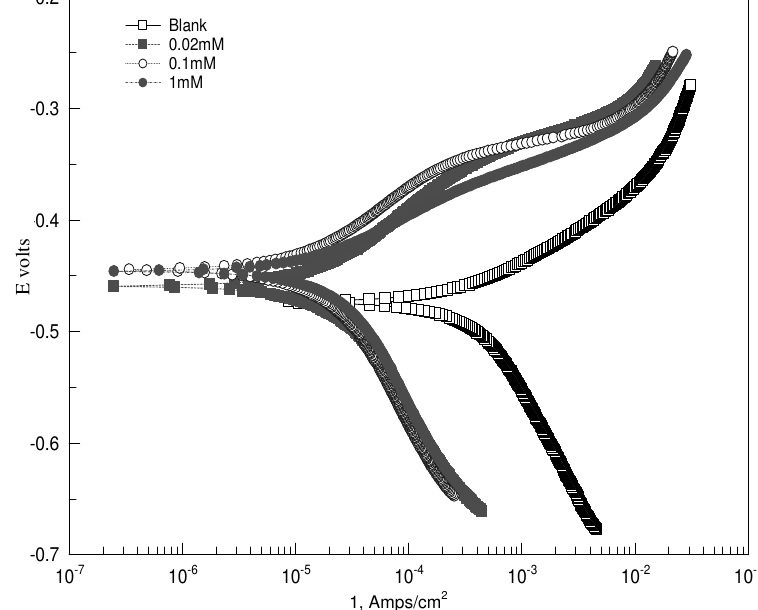
Figure 4. Polarization curves for mild steel recorded in 1 M H concentrations of inhibitor